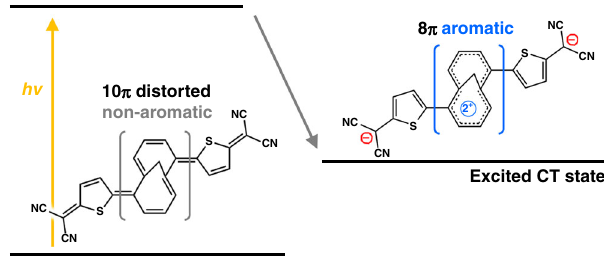
Fig. 1 Charge-transfer-induced excited-state aromatization. The molecular structure of TMTQ and schematic illustration for an excited-state aromatization induced by intramolecular CT